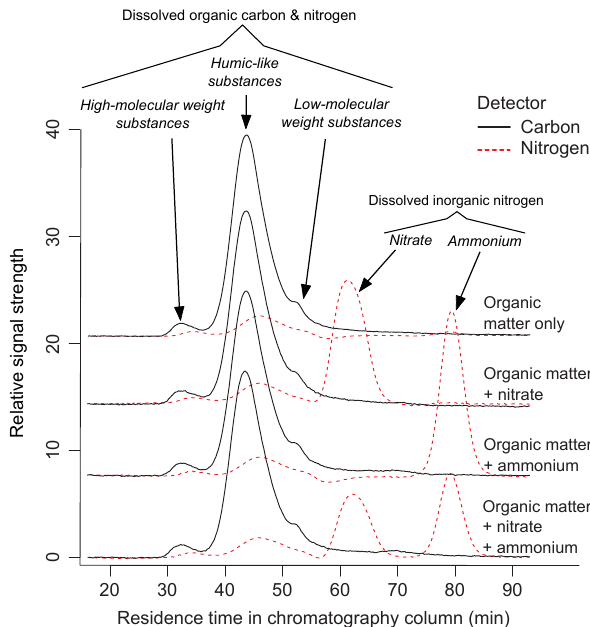
Figure A1. Typical chromatogram of size-exclusion chromatogra- phy to show the distribution of DOM fractions with and without added nitrate and ammonium. The sample for this chromatogram was taken at a wetland outflow in Brandenburg,